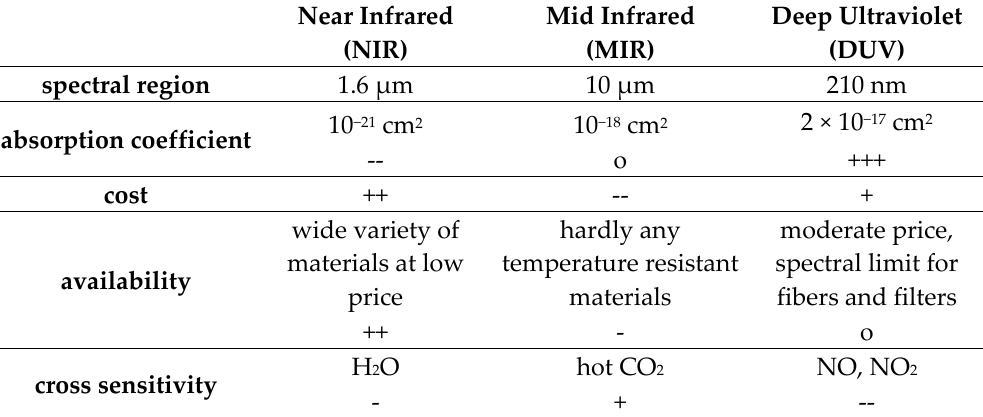
Table 1. properties of the three most sensitive ammonia absorption spectral